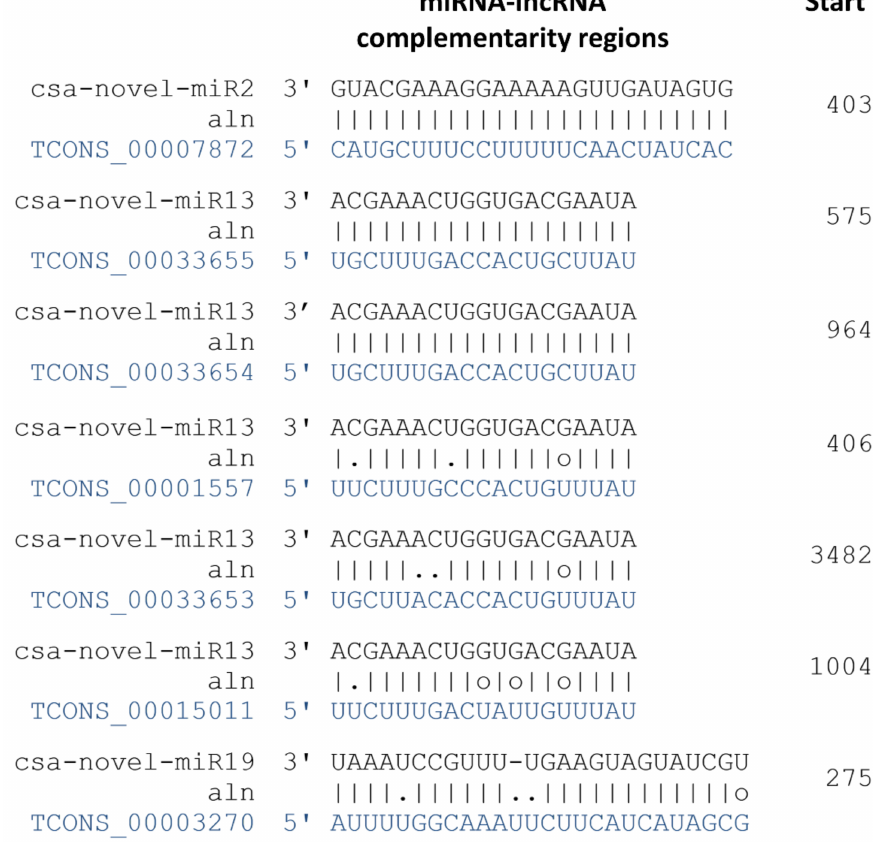
Figure 13. Identified endogenous target mimics (eTMs) of miRNAs. The ‘.’, ‘ − ‘, ‘o’, and ‘|’ represent mismatches, gaps, G:U pairs, and complementary bases,